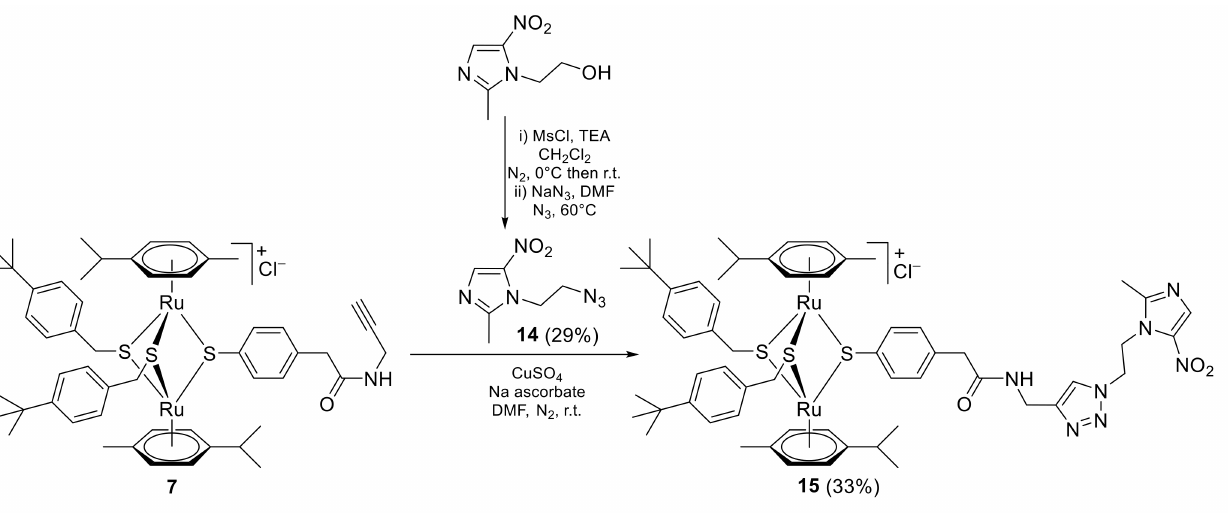
Scheme 3. Synthesis of the amide conjugates with the sulfa-drugs dapsone 8 , sulfamethoxazole 9 , sulfadiazine 10, sulfadox- ine 11 , and ester conjugates with triclosan 12 and metronidazole 13 .